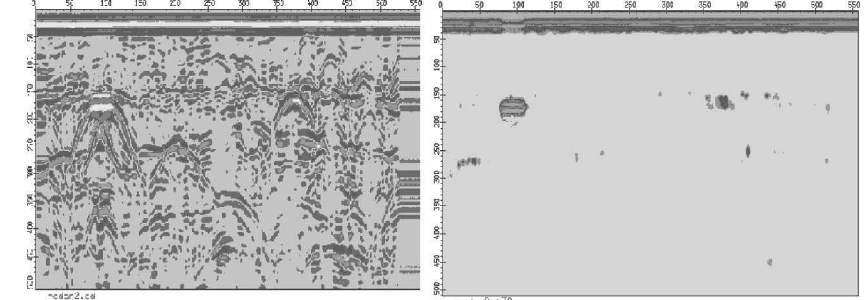
Figure 9. Subsurface radar sounding profile: before (left) and after (right) processing. Indi- vidual